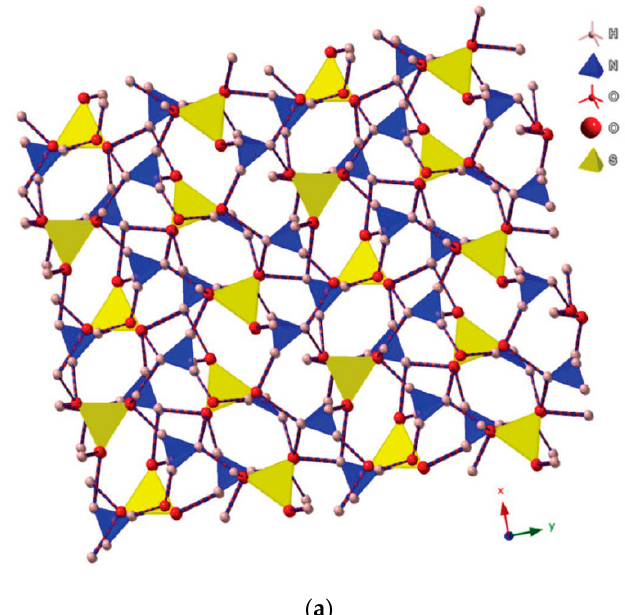
Figure 6. Reflectance spectra at room temperature and 193 K ( a ) and TG/DSC ( b ) analysis from room temperature to 773 and 1023 K of